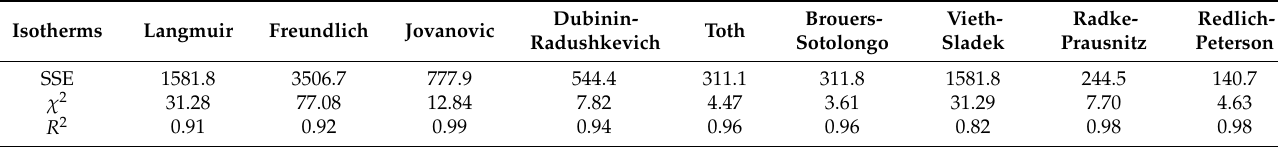
Table 3. Model fit factual